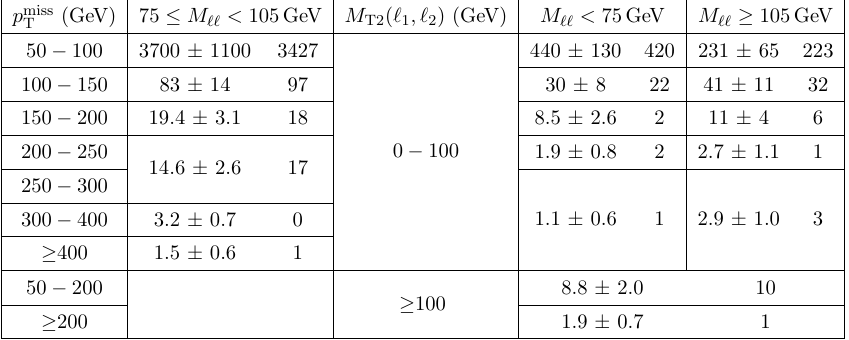
Table 14 . Category C: expected and observed yields in events with two e or (cid:22) forming and OSSF pair and one (cid:28) h . For each bin, the (cid:12)rst number corresponds to the expected yield and its uncertainty, and the second denotes the observed yield. The uncertainty denotes the total uncertainty in the yield.